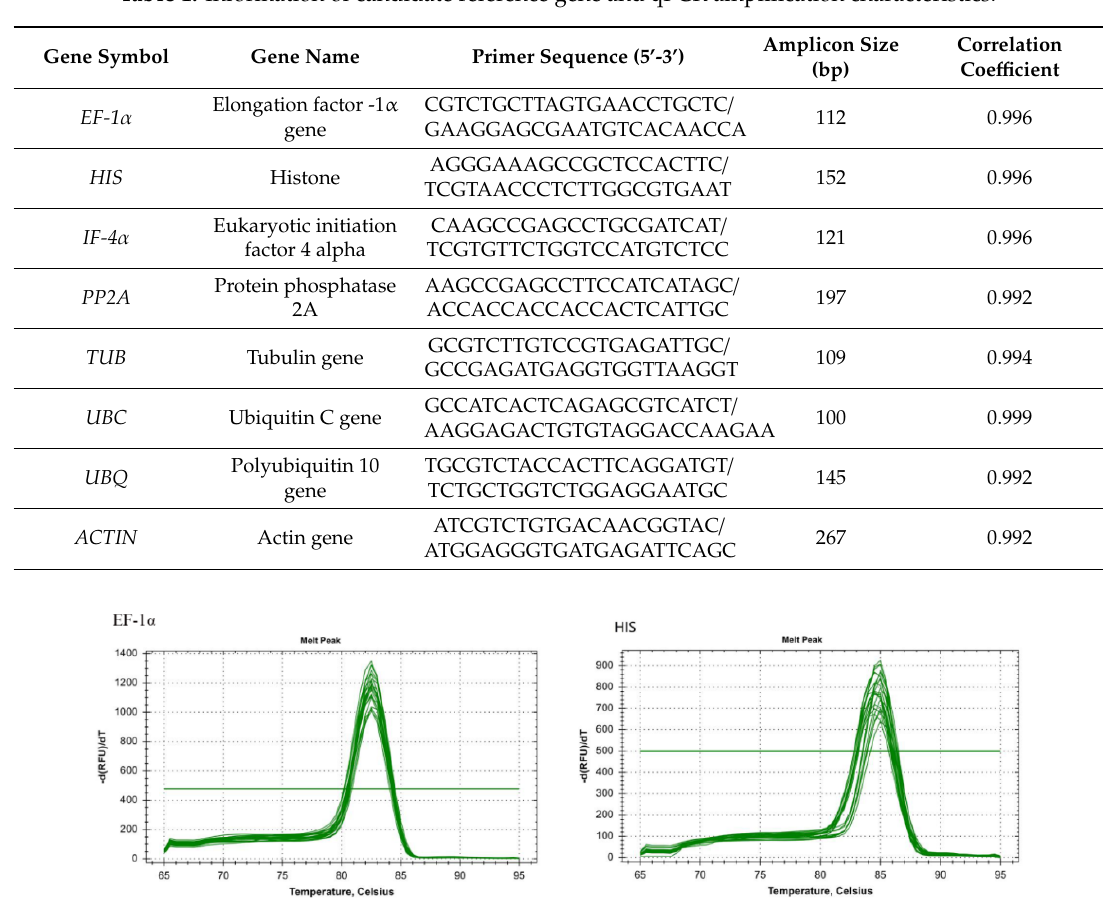
Table 1. Information of candidate reference gene and qPCR amplification characteristics.